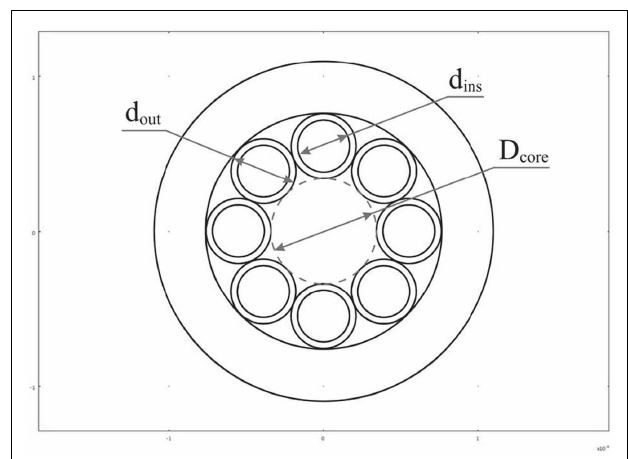
FIGURE 3 | HC-MOF with negative curvature of the core with cladding consisting of one row of capillaries (Pryamikov et al., 2011) .